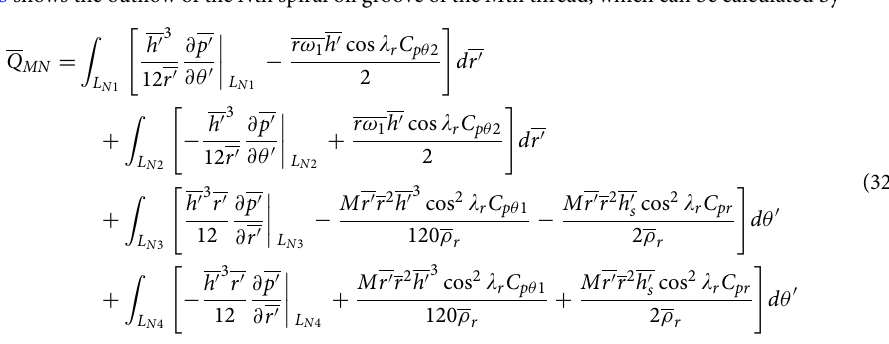
. where C res = 3 π d 4 c Neglecting the second and higher terms, the perturbed groove pressure can be given by (cid:31)(cid:30) Figure 8 shows the outflow of the N th spiral oil groove of the M th thread, which can be calculated by